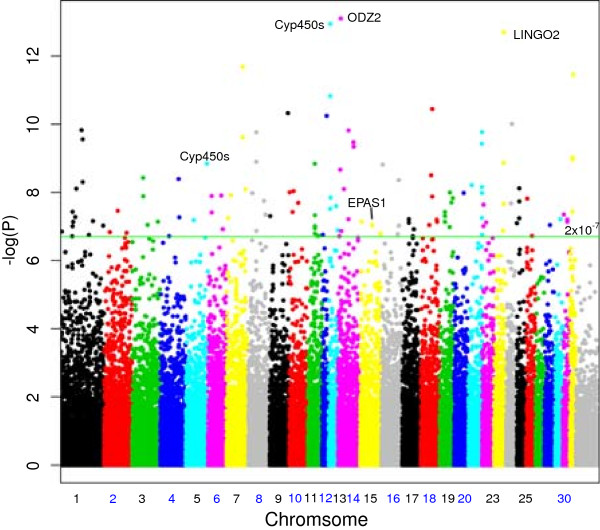
Plot of chromosomal position verses the –log ( p -value) for the frequency divergence between feral Andean horses and the comparison group. The green line represents a Bonferoni cut-off of p < 2 × 10-7.